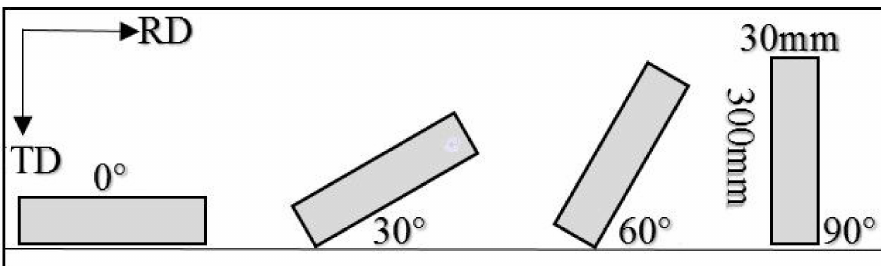
Figure 1. Schematic diagram of Fe-0.65%Si annealed